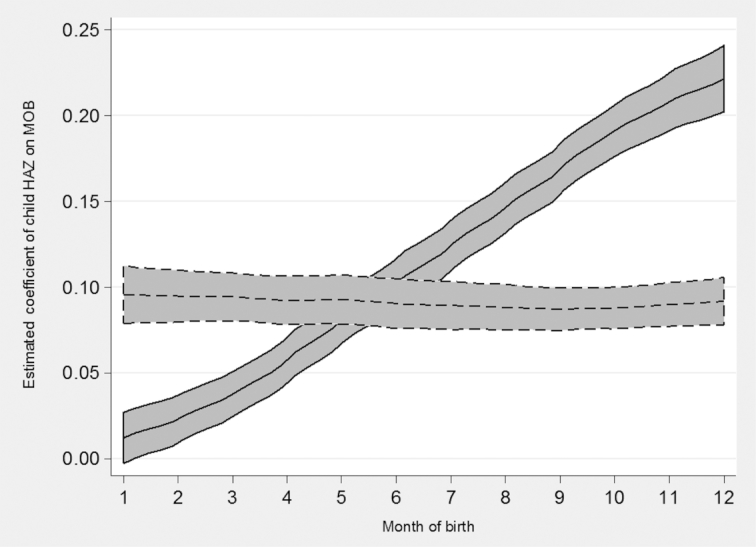
Estimated coefficients on child HAZ across 218 surveys. Lines are local polynomial smoothing regressions of degree zero with 95% CIs and an Epanechnikov kernel. Solid line is estimates before the linear correction for misreported MOB. Dotted line is after the linear correction for misreported MOB. HAZ, height-for-age z-score; MOB, month of birth.